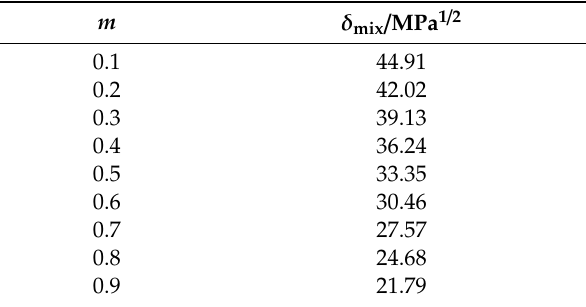
Table 2. Hansen solubility parameters ( δ mix / MPa 1 / 2 ) for di ff erent “PEG-400 + water” combinations free of ECT at “ T = 298.2